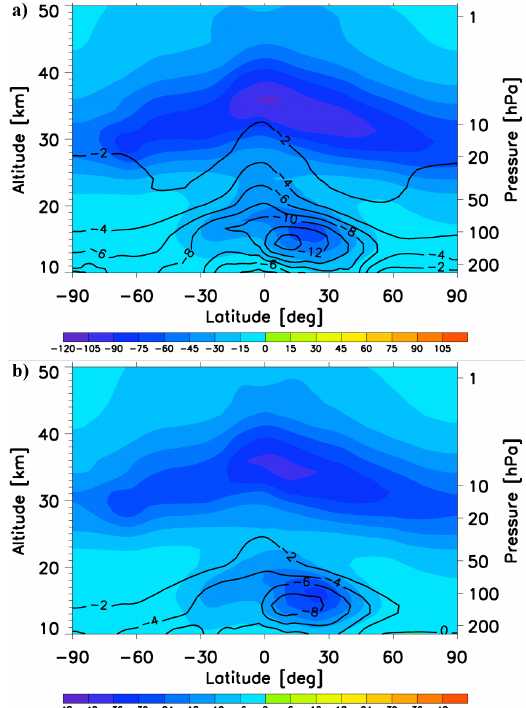
Figure 4. Annually, zonally averaged NO x concentration changes in units of pptv (shown by 2 Fig. 4. Annually, zonally averaged NO x concentration changes in color) and the relative change in % (shown by contours) in the H 2 -FC scenarios compared 3 units of pptv (shown by color) and the relative change in % (shown with the BL scenarios as a function of latitude and altitude for (a) A1FI and (b) B1 scenarios. 4 by contours) in the H 2 -FC scenarios compared with the BL scenar- ios as a function of latitude and altitude for (a) A1FI and (b) B1